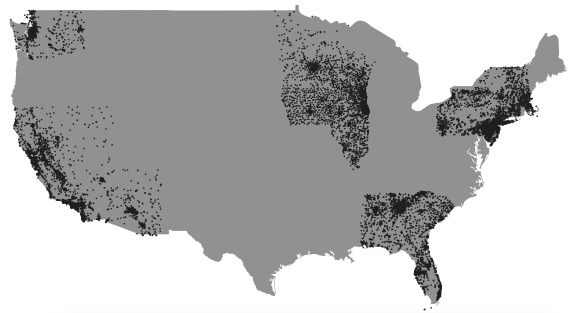
Figure 4. Geographical coordinates of 20,237 USA schools (partial schools dataset).